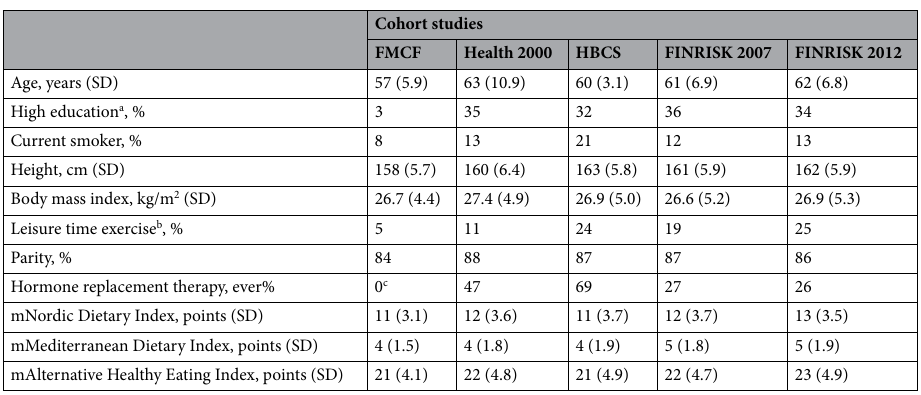
Table 2. Characteristics (median/%) of women included in the combined analysis of the association between dietary indices and postmenopausal breast cancer risk. a The total number of school years was divided into birth cohort specific tertiles with an exception of the Finnish Mobile Clinic Follow-up Survey where ‘highest education’ included those with more than upper secondary education. b Active, ≥ 3 times per week. c Hormone replacement therapy was not asked in Finnish Mobile Clinic Follow-up Survey. It was assessed to be ‘not used’ for all women as the treatment was rare in Finland in the 1970s 45